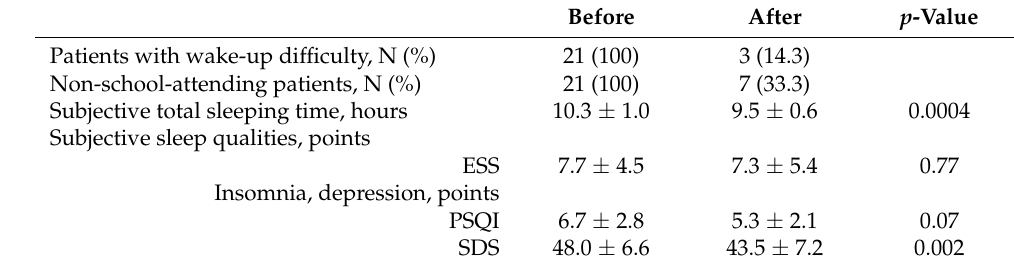
Table 3. Effects of the combination therapy on subjective sleep quality and depression.